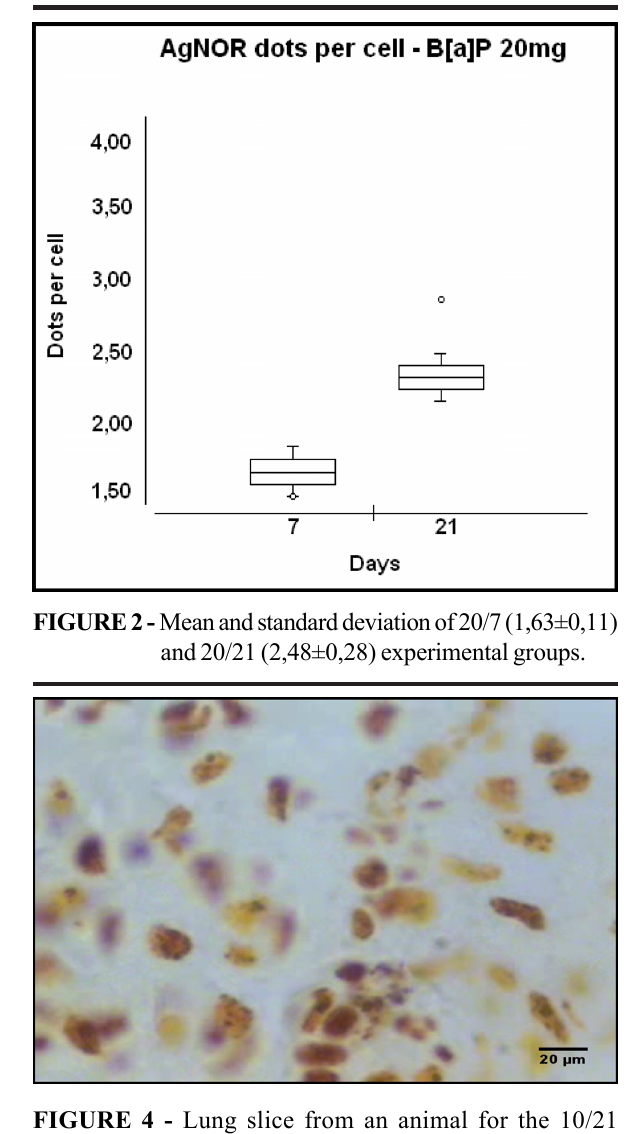
FIGURE 3 - Lung slice from an animal for the 20/21 experimental group. A cluster of cells showing silver-stained dots irregularly distributed and highly variable in size. (AgNOR method, original magnification X 1,000)